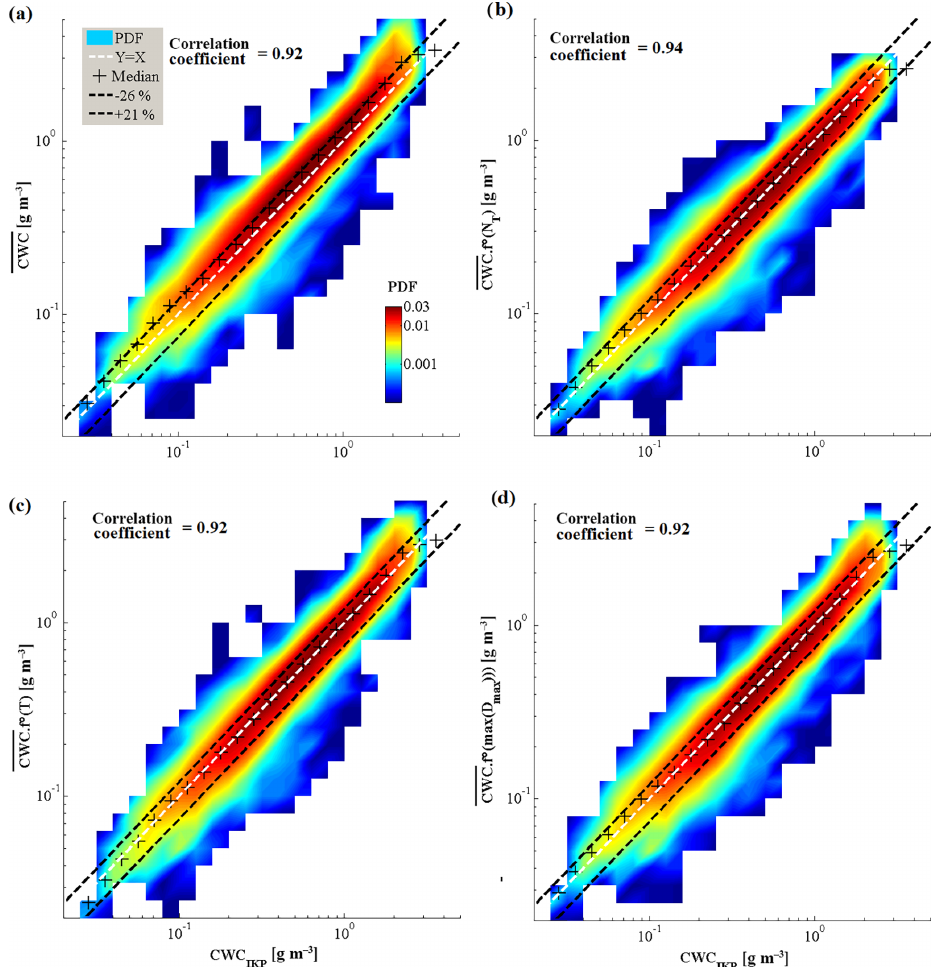
Figure 8. Probability distribution functions of CWC on the y axis calculated as a function of CWC IKP on the x axis. Probabilities are repre- sented by the colour scale and were normalized by the number of data points. (a) No correction is applied to average CWC. (b) Correction f (N T ) described by Eq. (9) is applied to CWC. (c) Correction f (T ) described by Eq. (10) is applied to CWC. (d) Correction f (max( D max )) described by Eq. (11) is applied to CWC. Dashed black lines represent the shift of retrieved CWSs when Z is shifted by more or less 1dBZ (RASTA uncertainty; Fontaine et al. 2014).